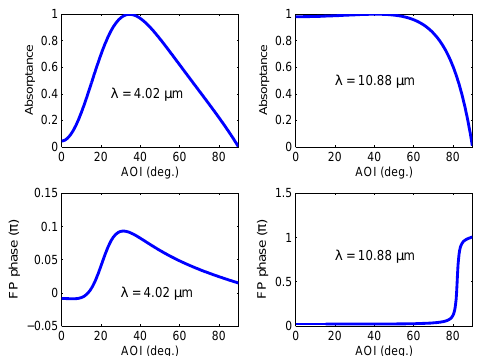
Figure 6: Top panels: absorptance of the DL/Cu bilayer vs. AOI at the perfect absorption wavelength of the shorter band λ = 4 . 02 µ m (left) and the longer band λ = 10 . 88 µ m (right). Bottom panels: total round-trip FP phase (cid:8) F (in the unit of π ) vs. AOI at the corresponding wavelength.